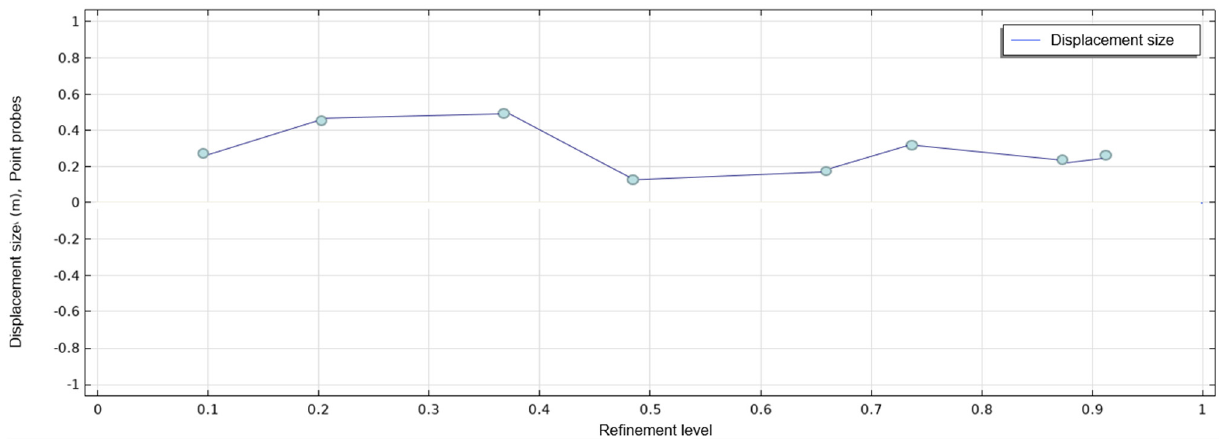
Figure 11. The Comsol Johnson-Cook model predicts a numerical graph of 8 nodes.